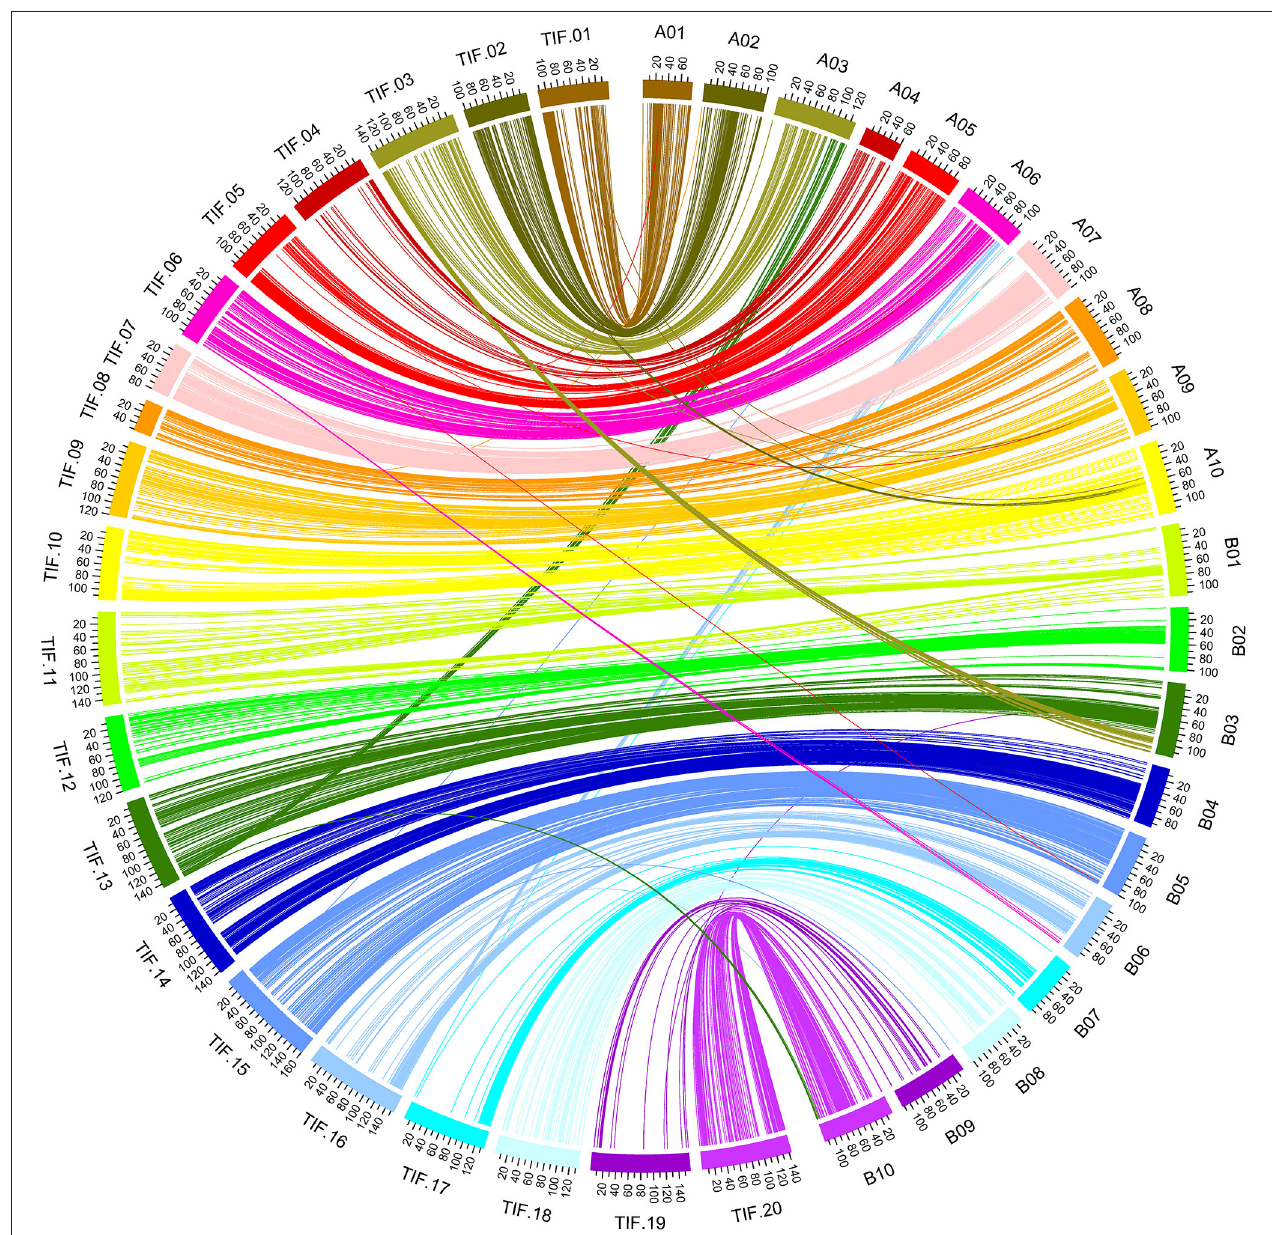
FIGURE 4 | Circos graph presentation of the genome synteny between genetic map and physical